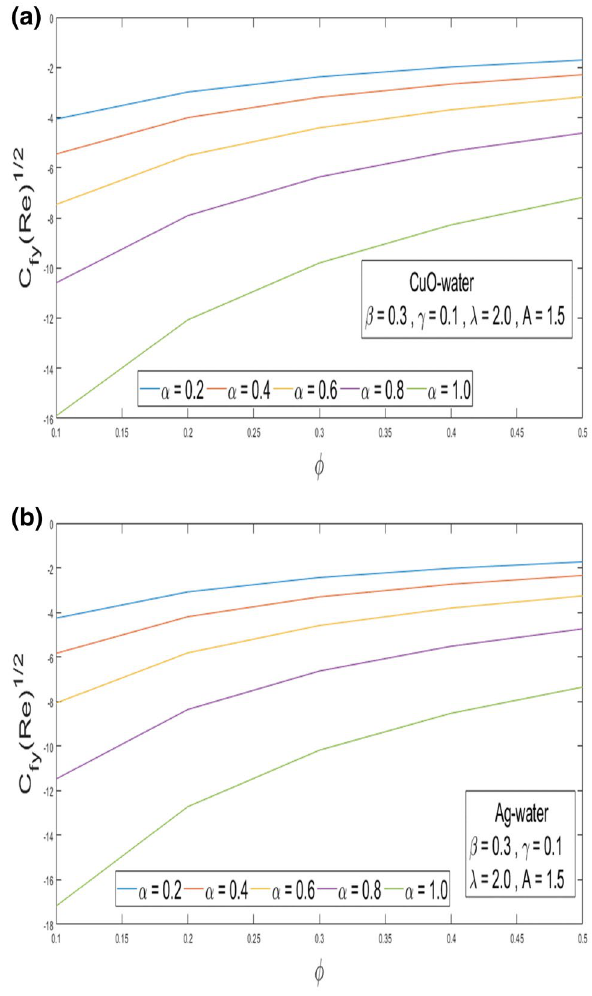
Figure 9. ( a ) Result of α and φ over C fy for CuO nanoparticle. ( b ) Result of α and φ above C fy for Ag